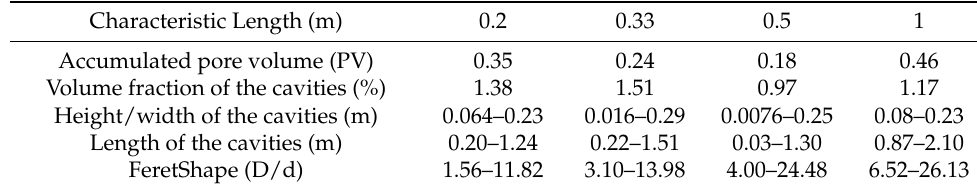
Table 3. Statistical cavity shape parameters for different characteristic lengths.